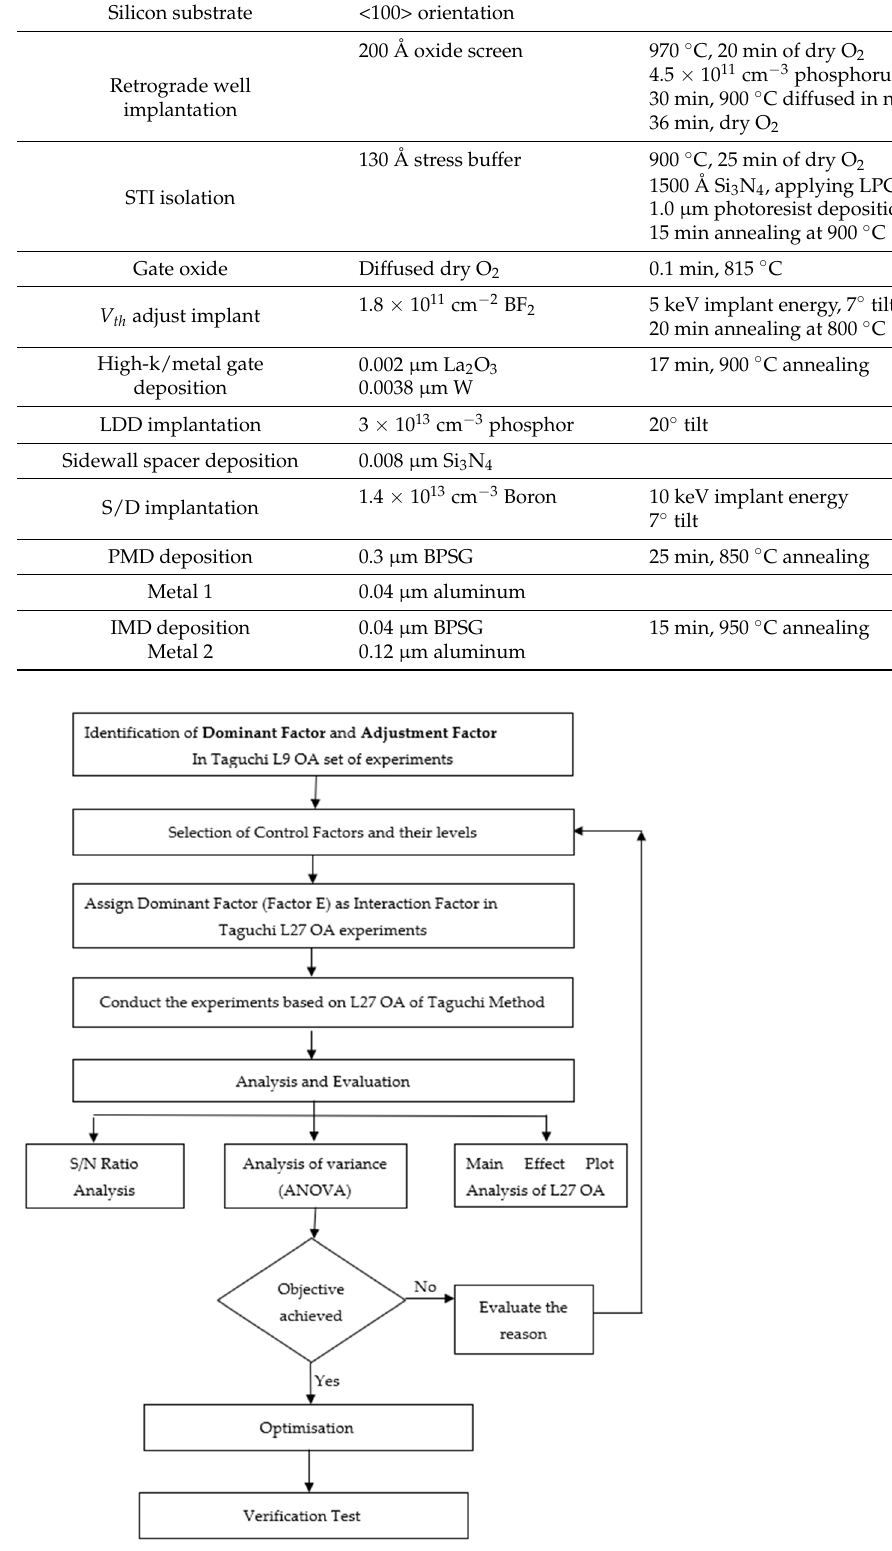
Figure 3. Taguchi analysis and ANOVA.